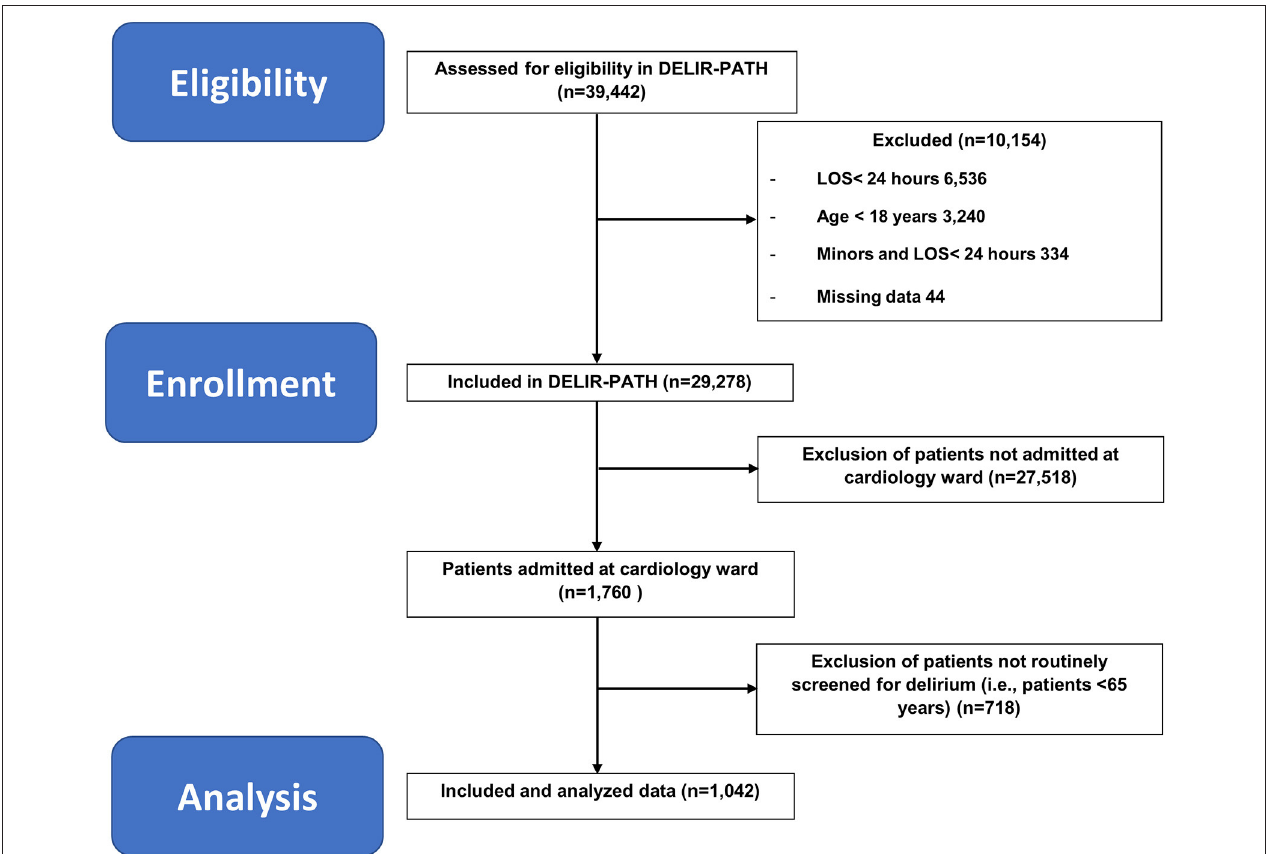
FIGURE 1 | STROBE flow chart of sample recruitment. DELIR-PATH, Detect Evaluate Control Inpatient Risk factors, Prevent And Treat Hospital-Acquired Deliriums; LOS, length of